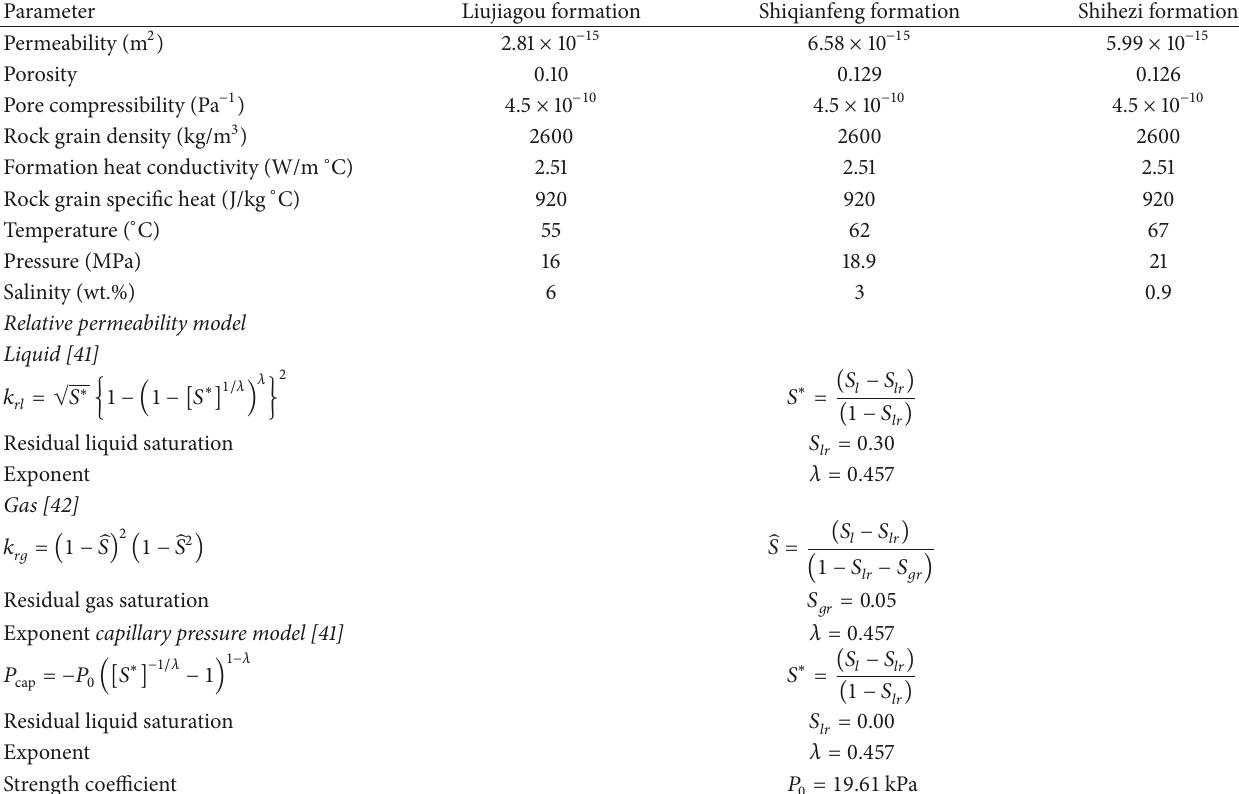
Table 1: Hydrogeological parameters of the formations used in this